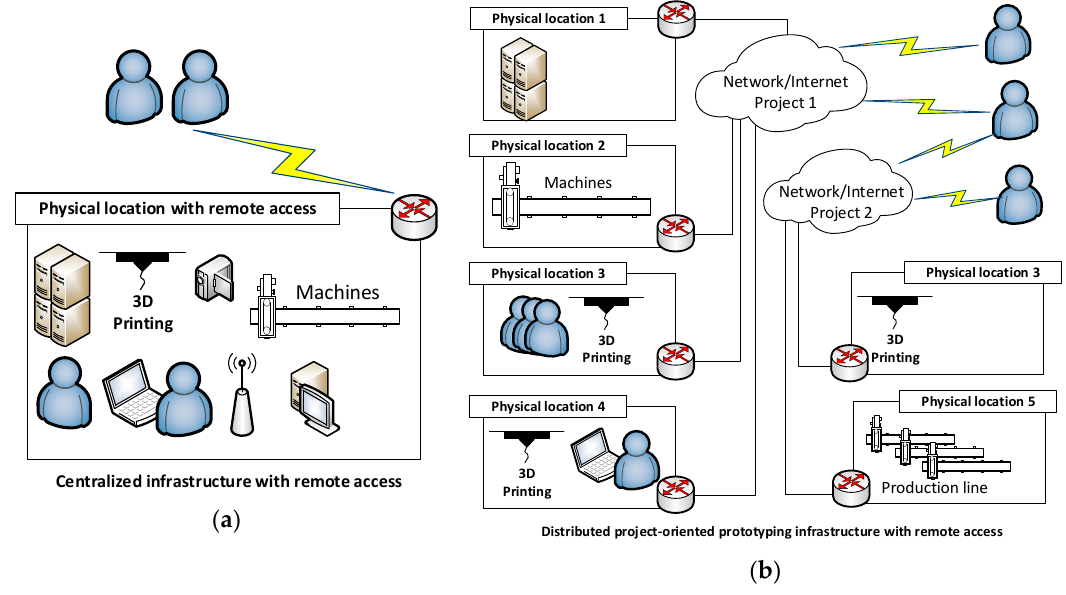
Figure 1. Types of prototyping system architecture: ( a ) Centralized infrastructure with remote access; ( b ) Distributed project-oriented prototyping infrastructure with remote access.